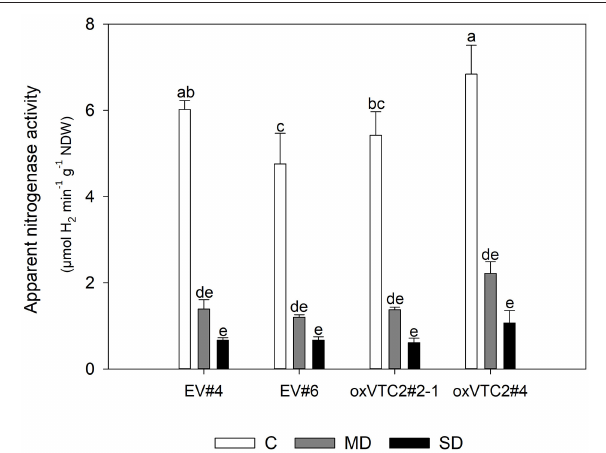
FIGURE 5 | Effects of drought stress on nitrogen fixation in M. truncatula empty vector (EV) and oxVTC2 plants under well-watered control (C), mild drought (MD), and severe drought (SD) conditions. Values represent the average ± SE ( n = 5 biological replicates). Mean values represented by the same letter do not differ statistically ( p ≤ 0.05 ANOVA test). NDW, nodule dry